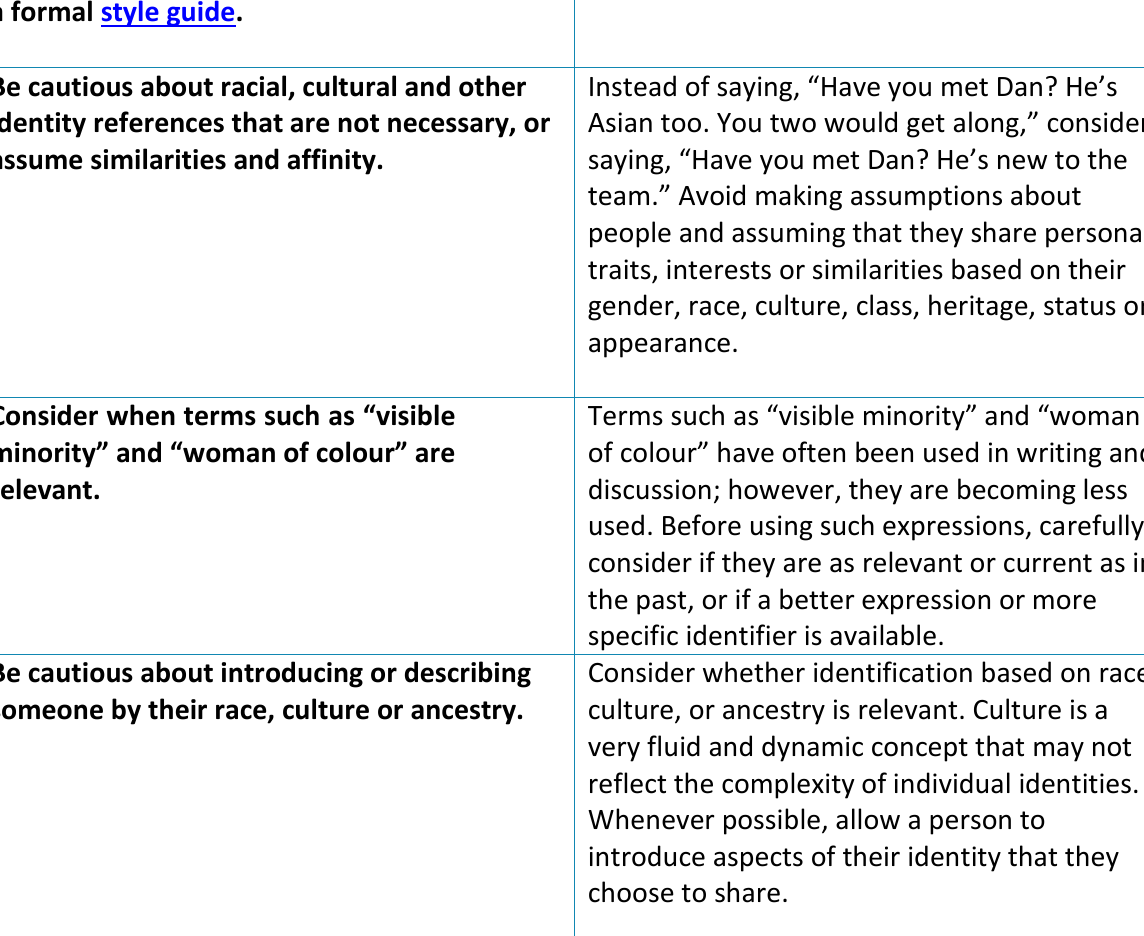
Page | 9 | Words Matter: Guidelines on Using Inclusive Language in the